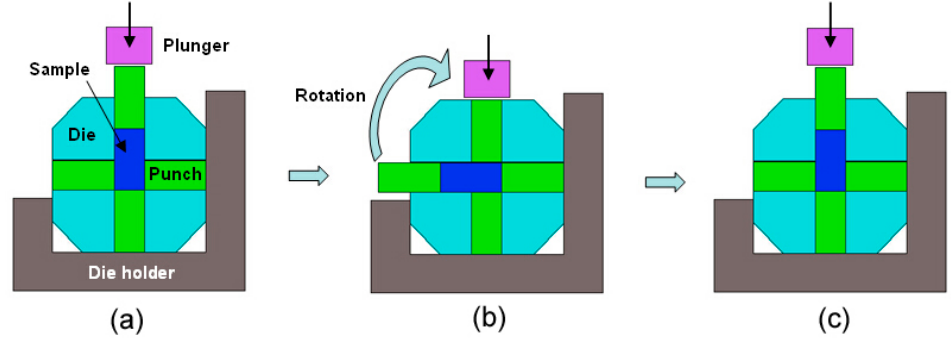
Figure 1. Diagrammatic drawing of RD-ECAP: ( a ) initial state; ( b ) rotation of the die; ( c ) after the rotation of the die.